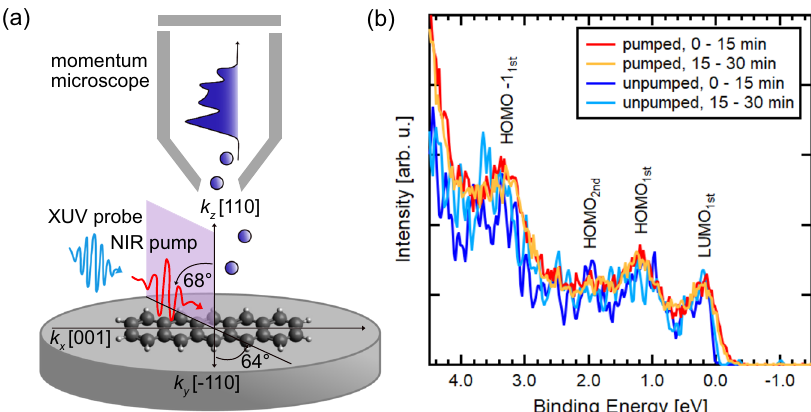
Fig. 1 Adsorption geometry of pentacene on Ag(110) and energy distribution curves of the pumped and unpumped valence region. a Schematic illustration of the experimental geometry. All of the pentacene molecules are adsorbed with the long molecular axis along the [001] direction of the silver substrate. Pump and probe pulses are aligned to coincide in the same sample region. b Time-integrated photoelectron spectra for a bilayer of pentacene on Ag(110) with an excitation energy of h ν = 35 eV. The measurements are taken at the same sample position for a total measurement time of 30 min. Within a bunch train of 330 pulses with 1 µ s spacing at a repetition rate of 10 Hz, 299 bunches are optically pumped (red and orange lines). The dark and light blue lines show the time-integrated signals of the 31 unpumped bunches. LUMO 1st , HOMO 1st , HOMO-1 1st of the fi rst layer and HOMO 2nd of the second layer are indicated in the spectra. The spectra are normalized at 2.15 eV binding energy. The LUMO 1st is partly fi lled due to charge transfer from the